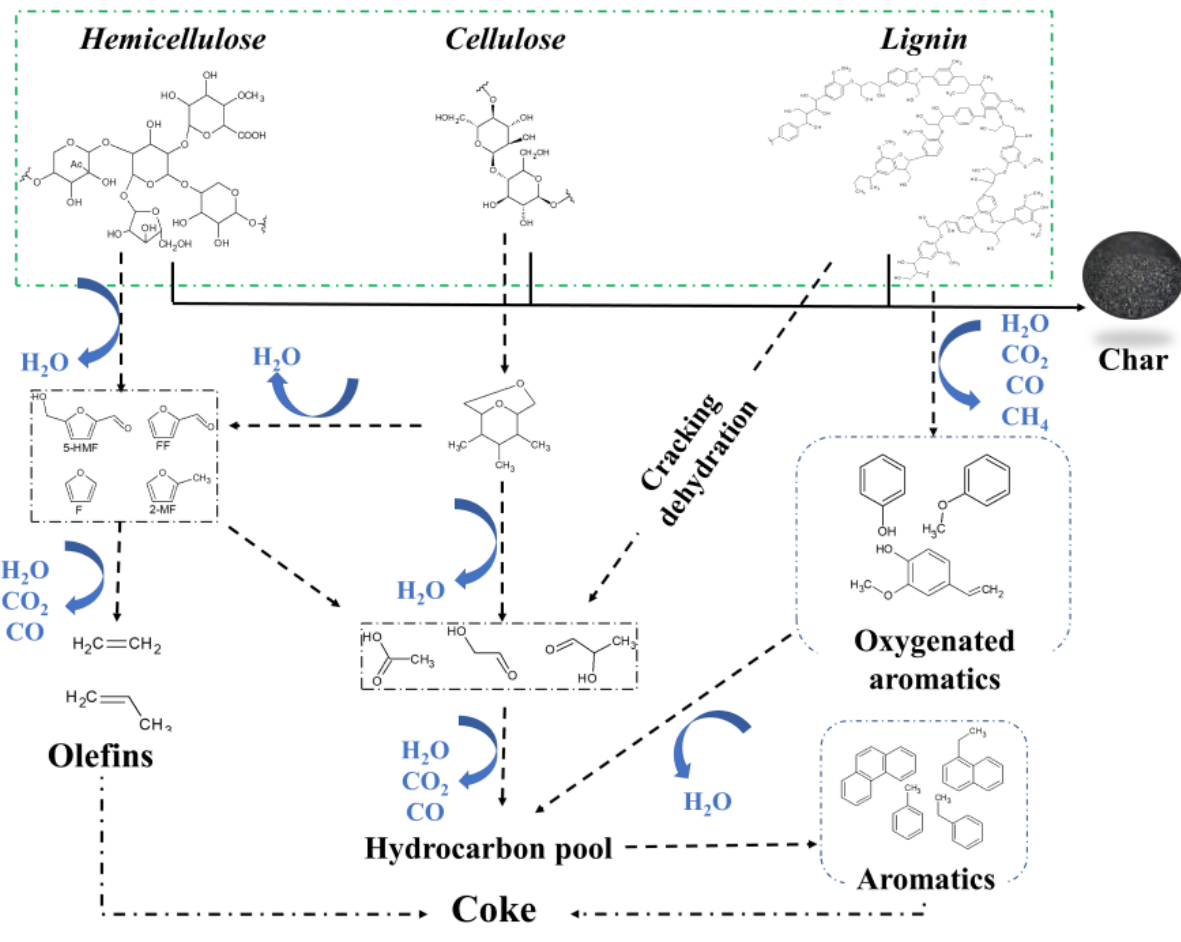
Figure 3. Reaction pathways of biomass pyrolysis over a zeolite. Based on Wang et al. 2022